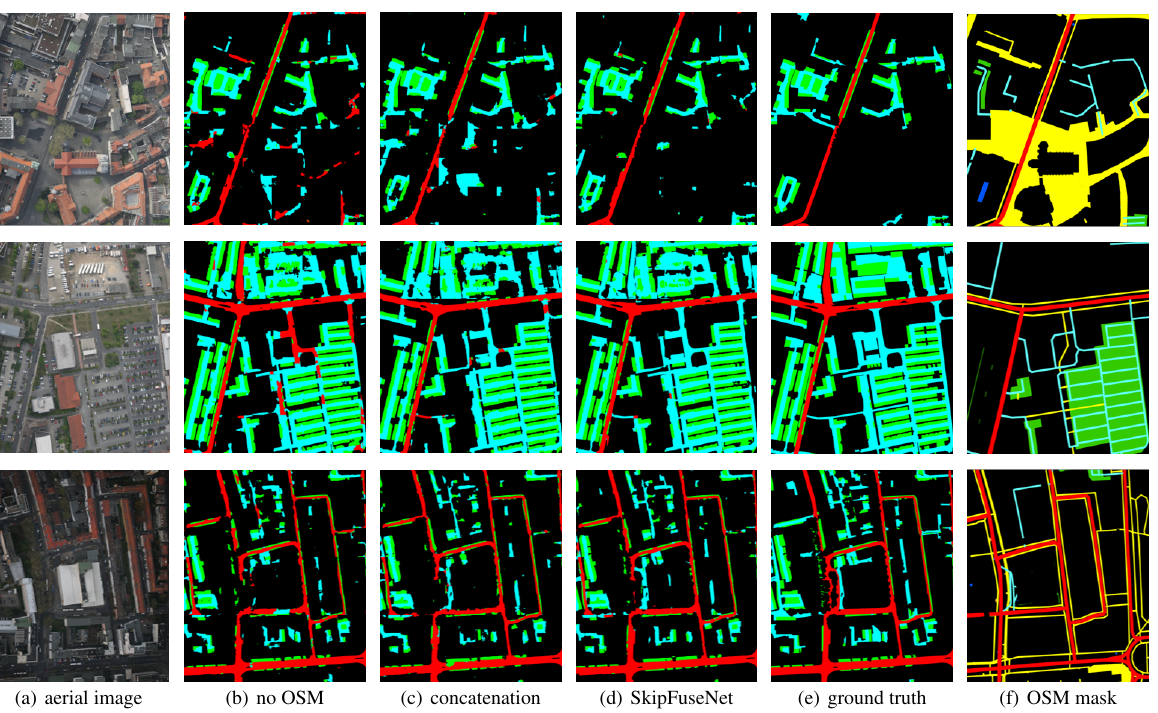
Figure 7. Qualitative comparison of the impact of OSM and the different fusion schemes on the models with a Dense-U-Net backbone. Categories colors are: ∎∎∎∎∎∎∎∎∎∎∎∎∎∎∎∎∎ parking area, ∎∎∎∎∎∎∎∎∎∎∎∎∎∎∎∎∎ road, ∎∎∎∎∎∎∎∎∎∎∎∎∎∎∎∎∎ access way, ∎∎∎∎∎∎∎∎∎∎∎∎∎∎∎∎∎ pedestrian/bike way and ∎∎∎∎∎∎∎∎∎∎∎∎∎∎∎∎∎ bicycle